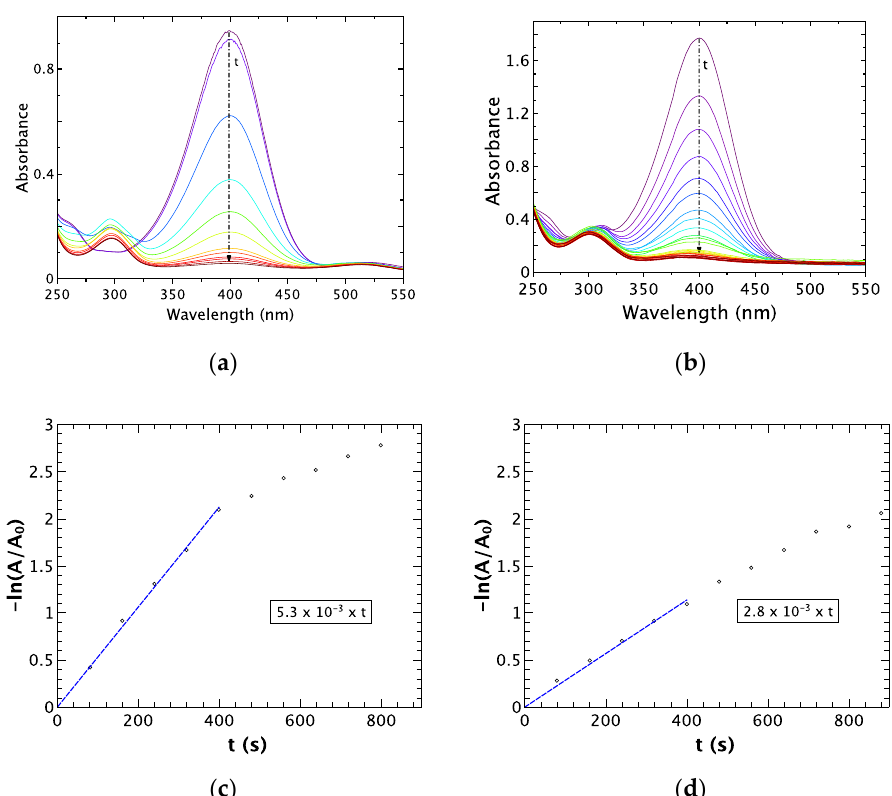
Figure 4. UV-vis spectra of 4-nitrophenol reduction as function of time and chemical reaction kinetics determination, respectively for ( a , c ) AuNPs and ( b , d ) AgNPs (pH = 10; T = 35 °C; 5 µg of metal; 10 μL of 4-nitrophenol at 1 × 10 −2 µmol/L and 50 μL of NaBH 4 at 0.4 µmol/L).